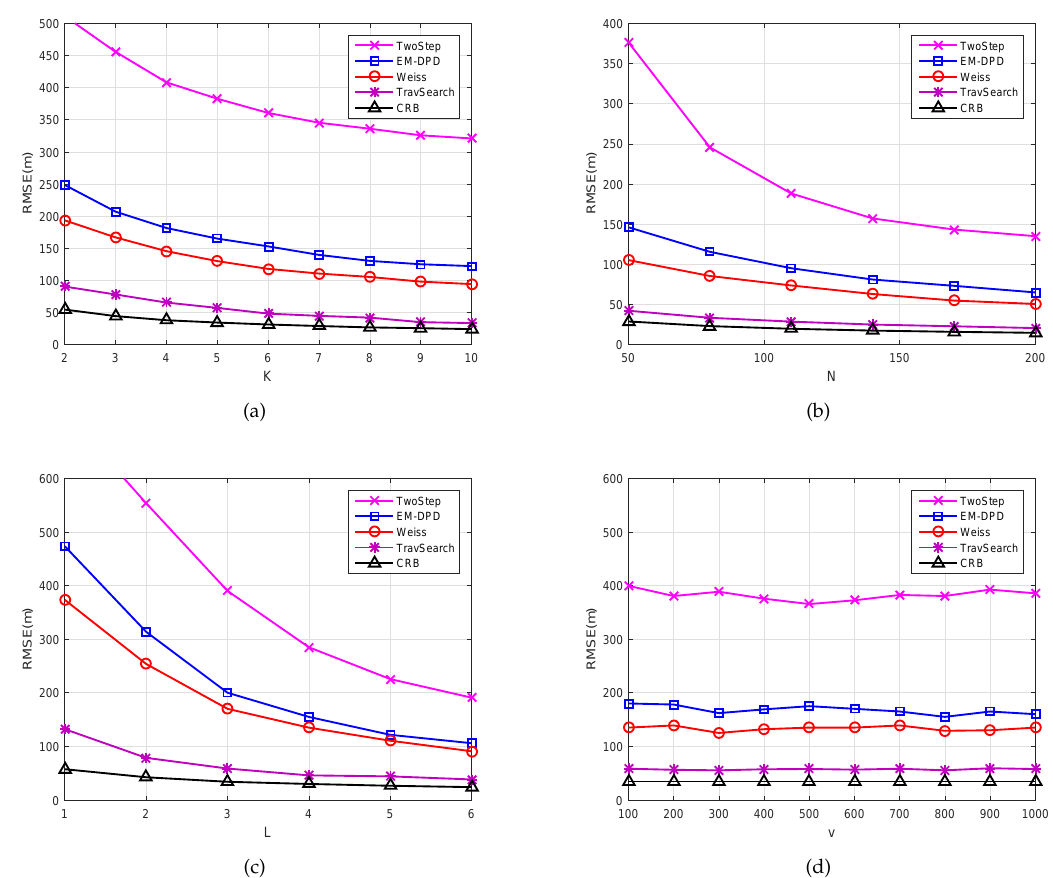
Figure 5. The RMSEs of different algorithms versus system parameters: ( a ) the value of K ; ( b ) the value of N ; ( c ) the value of L ; ( d ) the value of v